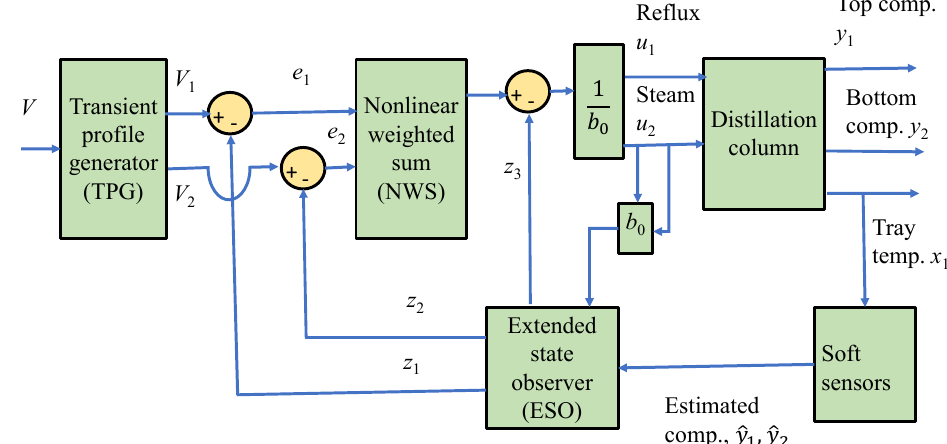
Figure 3. Inferential ADRC control scheme.